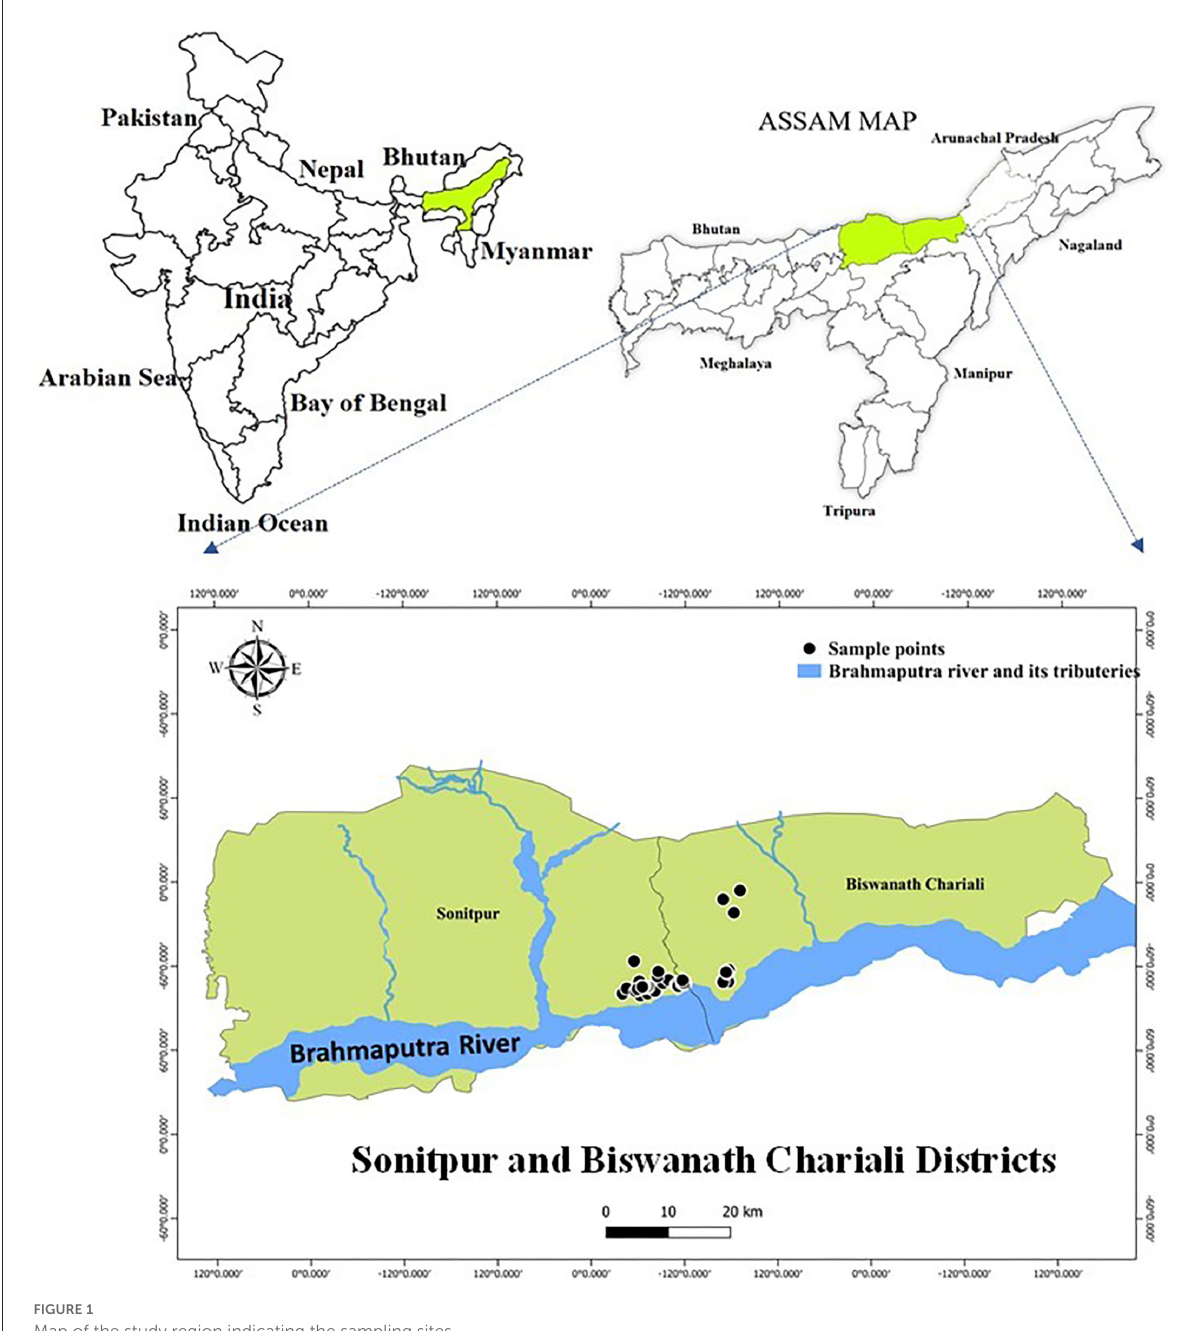
FIGURE1 Map of the study region indicating the sampling sites.